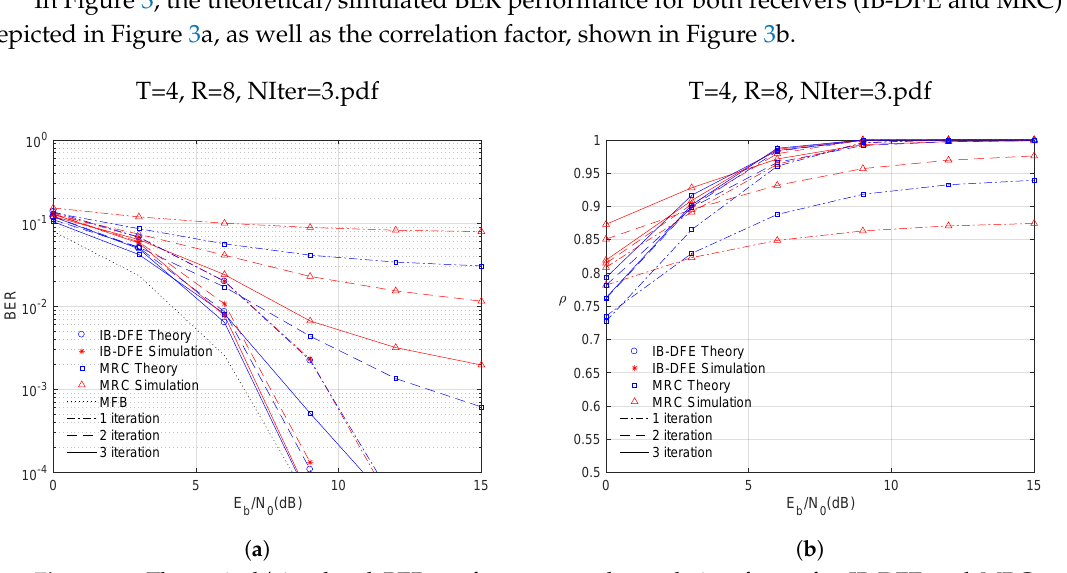
Figure 3. Theoretical/simulated BER performance and correlation factor for IB-DFE and MRC receivers in a Multiple Input Multiple Output (MIMO) system with 3 iterations. ( a ) BER performance. ( b ) Correlation factor ( ρ